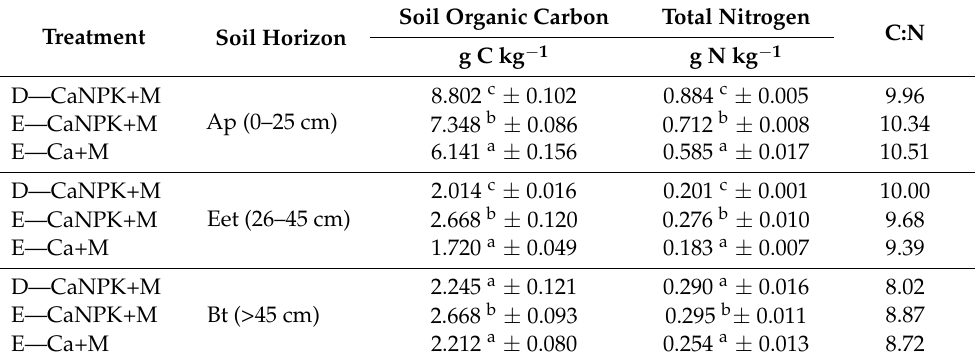
Table 1. Average content (mean ± SD) of soil organic carbon, total nitrogen, and C/N ratio in soil horizons of Ca+M and CaNPK+M treatments under rye monoculture and 5-crop rotation experiments. Soil Organic Treatment Soil Horizon